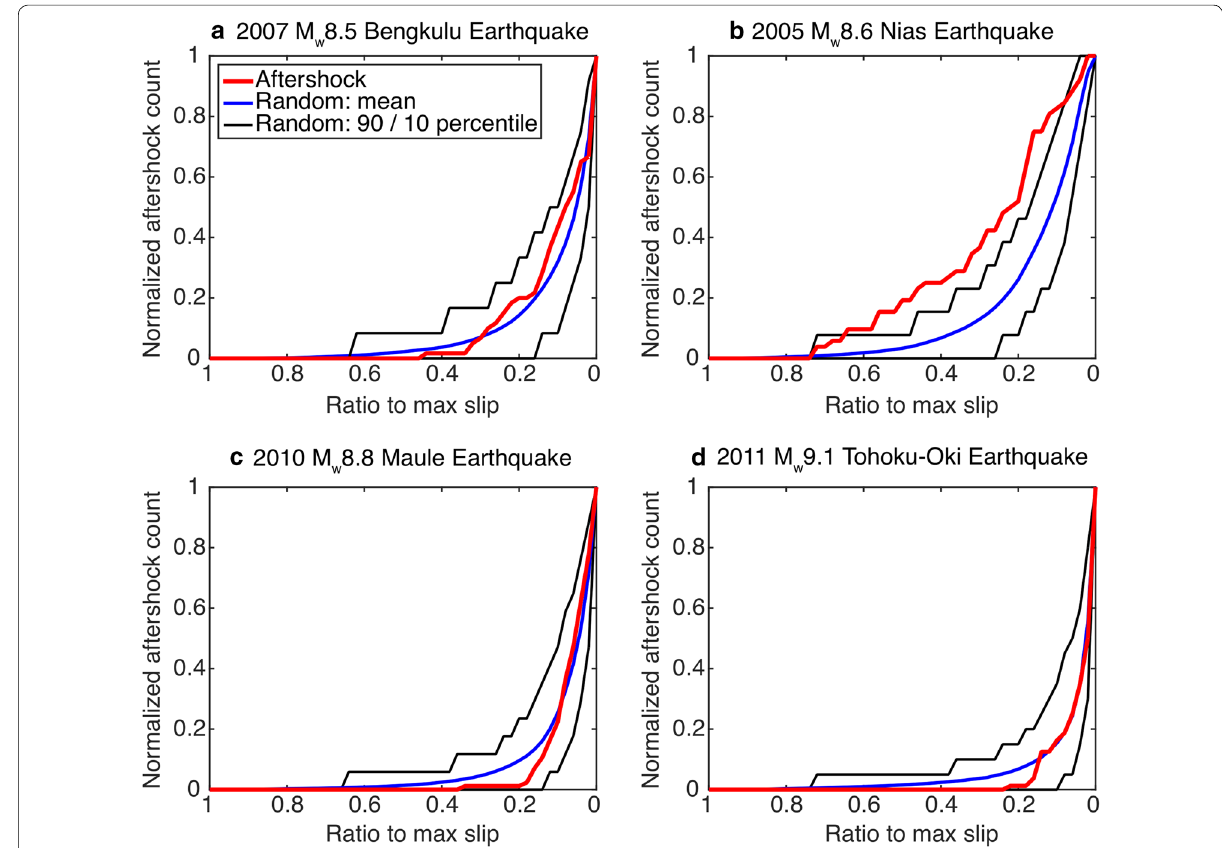
Fig. 10 Statistical significance tests of the aftershock locations relative to the mainshock slip for the a Bengkulu, b Nias, c Maule, and d Tohoku‑Oki earthquakes. The axes are the same as in Fig. 9. The figure shows the average of the observed distribution (red) for the slip inversion results using different EGFs, as well as the mean (blue), and 10th and 90th percentiles (black) of the combined distribution of the 5000 bootstrapping realizations of random scattering of the same amount of aftershocks as in the actual observation onto each slip image using each